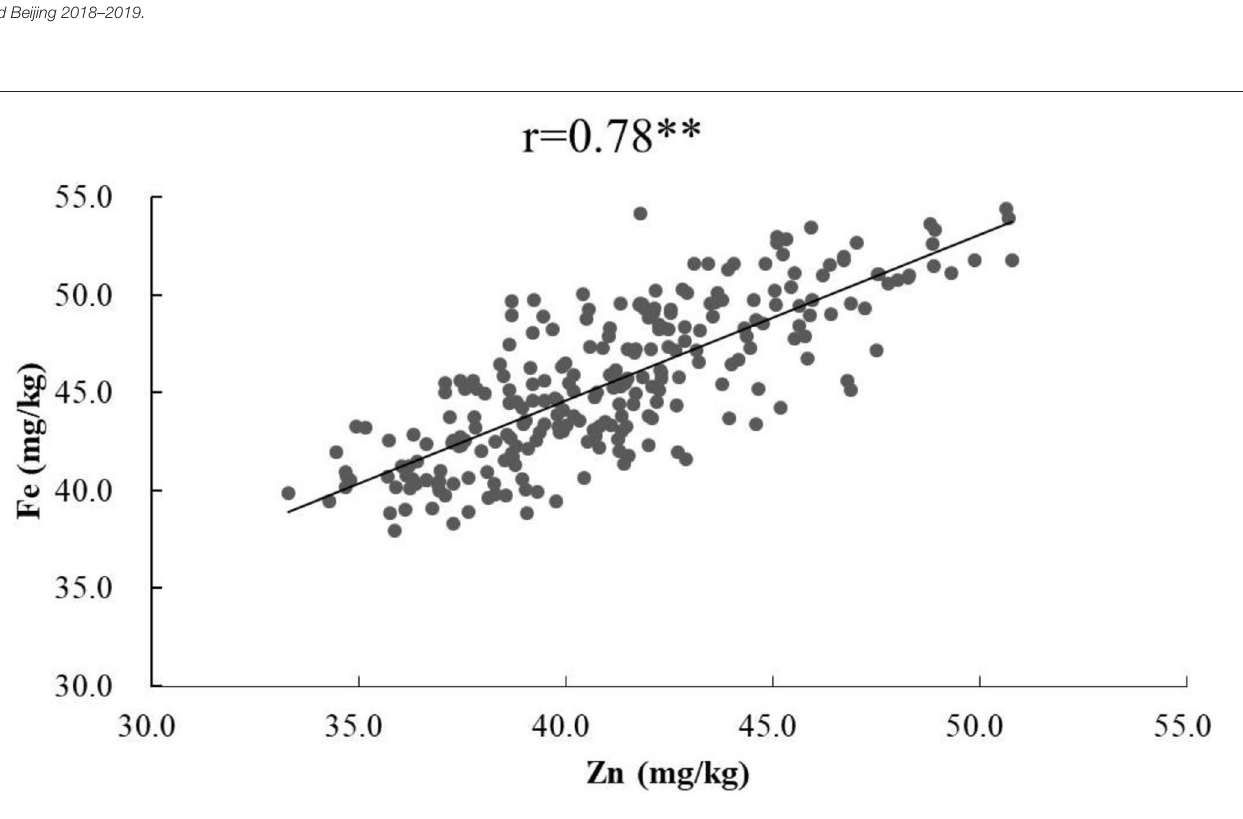
FIGURE 2 | Phenotypic correlation of GZn with GFe based on BLUEs across nine environments in the Jingdong 8/Bainong AK58 RIL